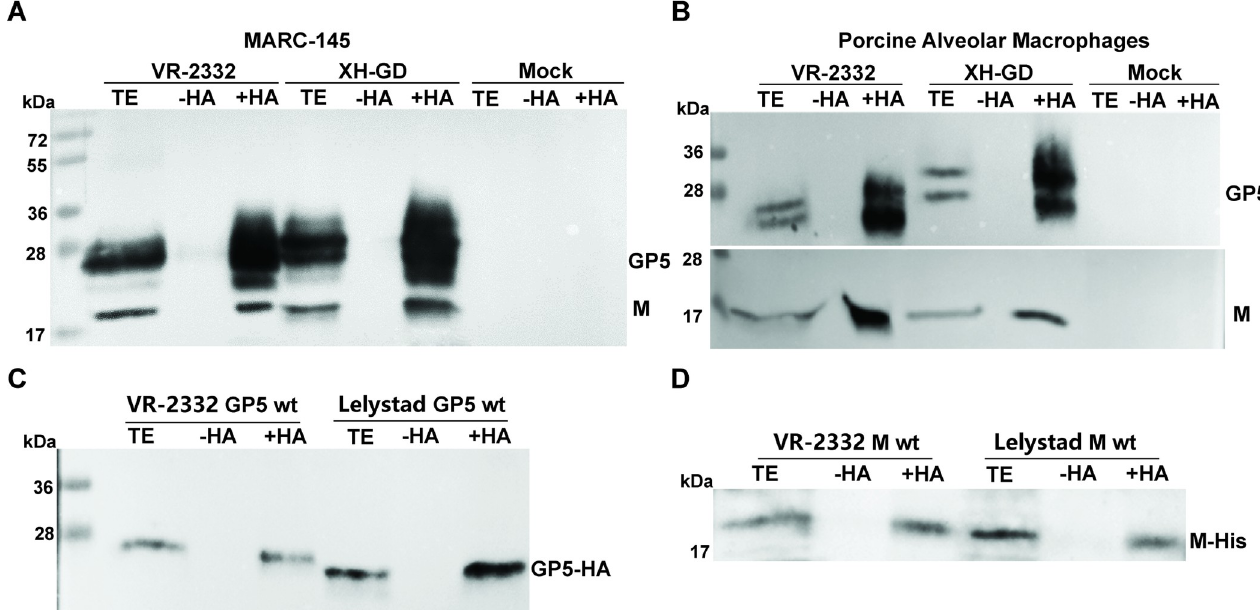
Fig 2. Palmitoylation of GP5 and M of PRRVS-1 and PRRSV-2 strains. (A) GP5 and M of two PRRSV-2 strains are palmitoylated in infected MARC-145 cells. Cells were left uninfected (mock) or infected with VR-2332 or XH-GD at MOI of 0.001, lysed after 48h and subjected to Acyl-Rac to detect palmitoylated proteins. Cell lysates were divided into two aliquots either treated (+HA) or not treated with hydroxylamine (-HA). TE: total extraction: 10% of the cell lysate before hydroxylamine treatment. Samples were analyzed by western blotting with a mixture of monoclonal antibodies against GP5 and M. (B) GP5 and M of two PRRSV-2 strains are palmitoylated in infected PAM cells. Cells were left uninfected (mock) or infected with VR-2332 or XH-GD at MOI of 0.001, lysed after 48h and subjected to Acyl-Rac to detect palmitoylated proteins. Palmitoylation was analyzed with Acl-Rac as described in legend to Fig 1A except that monoclonal antibodies against GP5 and M were applied to different membranes. (C) and (D) Palmitoylation of GP5-HA and M-His in transfected 293T cells. GP5 (equipped with a C-terminal HA-tag) and M (equipped with a C-terminal His-tag) from VR-2332 and Lelystad strains were expressed in 293T cell. 48 hours after transfection acylation of GP5 and M was analyzed using Acyl-RAC and Western Blot with antibodies against the HA-tag (C) or the His-tag (D). The left part of each blot shows the mobility of molecular weight markers with the indicated masses in kDa.